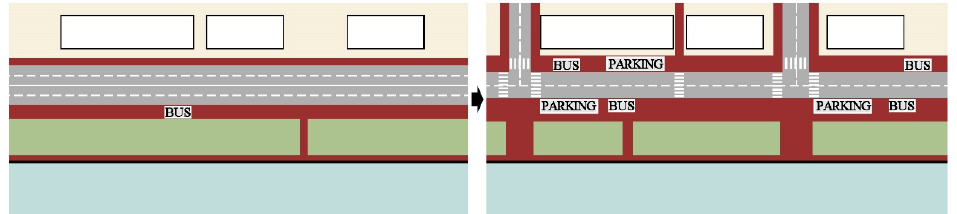
Figure 10. Urban design strategies for external traffic in Beijing’s waterfront.